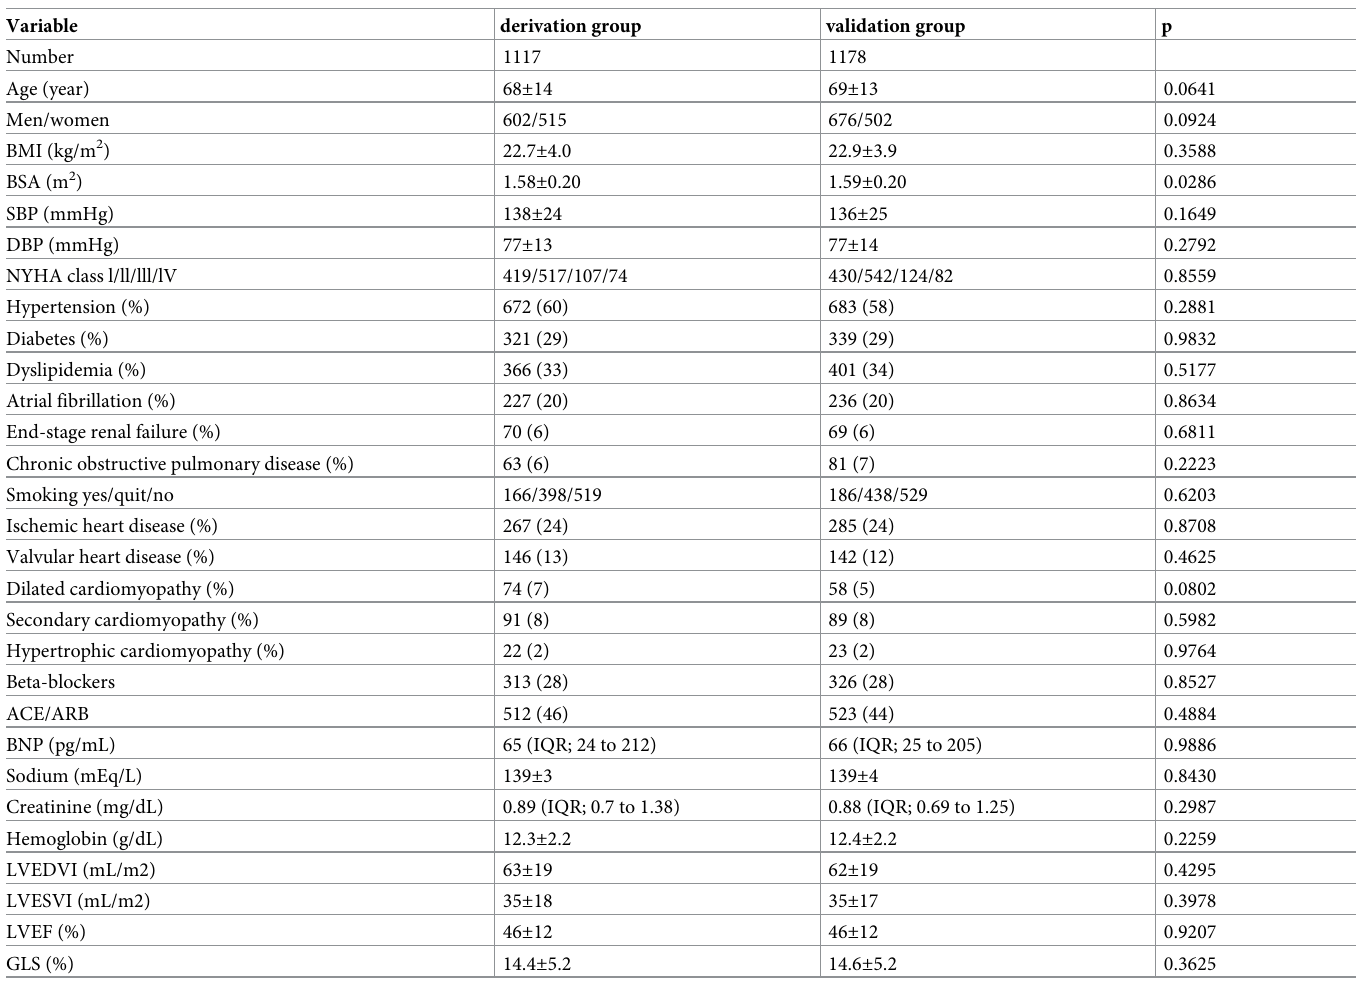
Table 1. Characteristics of the study